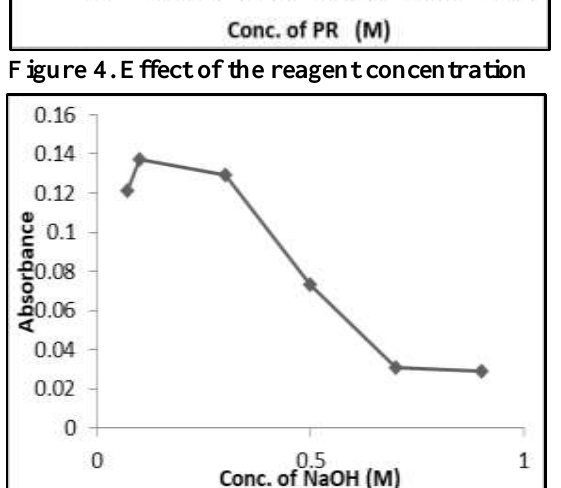
Figure 5. Effect of NaOH concentration